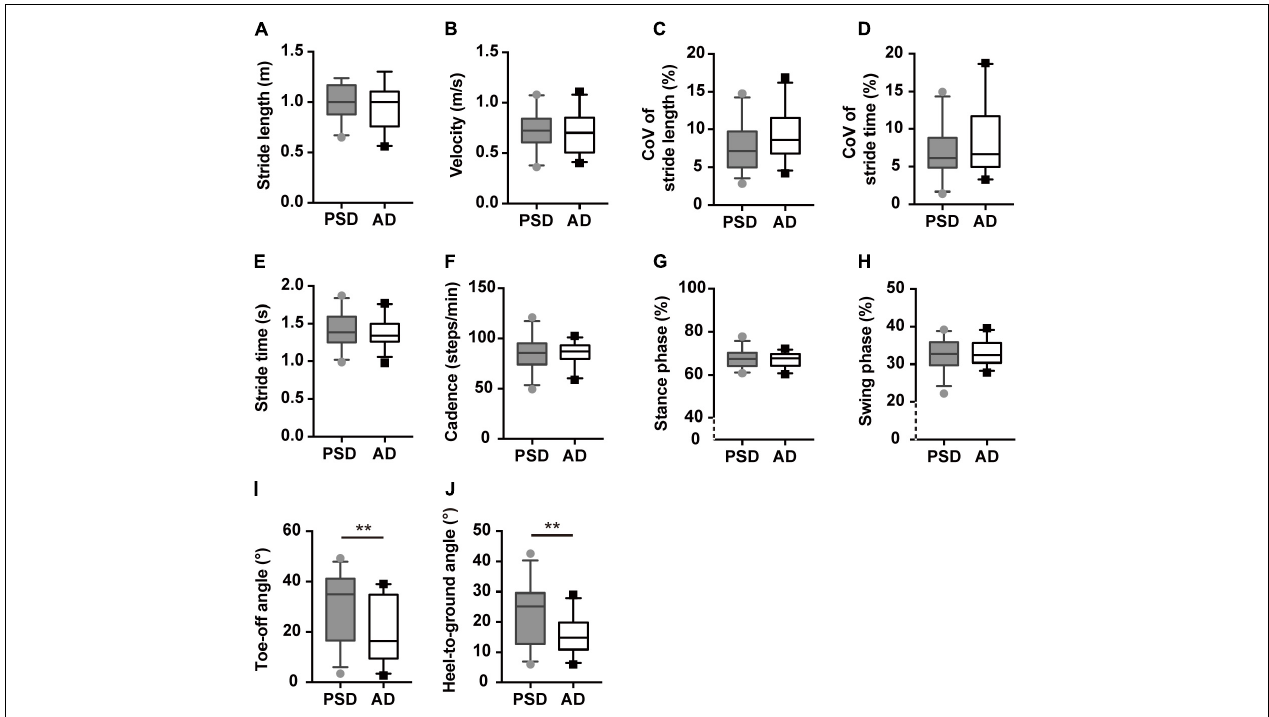
FIGURE 4 | Gait characteristics comparisons of patients with PSD and patients with AD showed in the naming animals-task gait test. (A,B) The pace domain of stride length and walking speed. (C,D) The variability domain of CoV SL and CoV ST . (E–H) The rhythm domain of stride time, cadences, percentages of stance, and swing phases. (I,J) The ToA and HtA of patients with PSD and patients with AD showed in the naming animals-task gait test. ** p ≤ 0.01. PSD, post-stroke dementia, AD, Alzheimer’s disease, CoV, coefficient of variance.